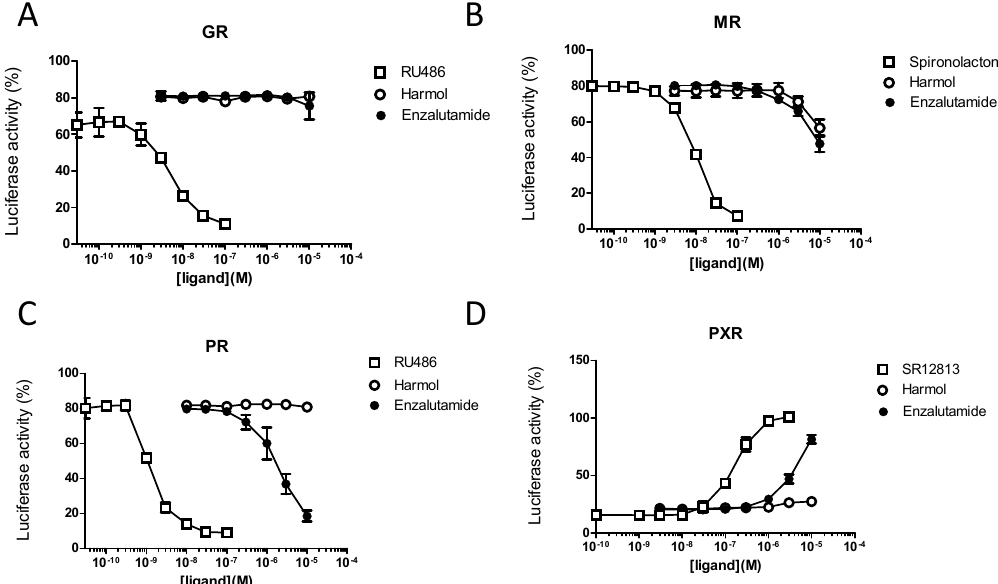
Figure 6. Harmol hydrochloride is a selective AR antagonist and does not activate the pregnane X receptor (PXR). HMLN glucocorticoid receptor (GR), HG5LN mineralocorticoid receptor (MR), HELN progesterone receptor (PR) and HG5LN PXR cells were used to evaluate the antagonistic effect of the tested compounds on ( A ) the glucocorticoid receptor (GR), ( B ) the mineralocorticoid receptor (MR), ( C ) the progesterone receptor (PR) and ( D ) the agonistic activity towards the pregnane X receptor (PXR). Each cell line was incubated for 16 h, with increasing concentrations of the indicated compound in the presence of 5 nM dexamethasone (for GR), 1 nM aldosterone (for MR) and 1 nM R5020 (for PR). RU486 and spironolactone were used as competitive antagonist controls for GR, PR, and MR, and SR12813 as an agonist control of PXR.